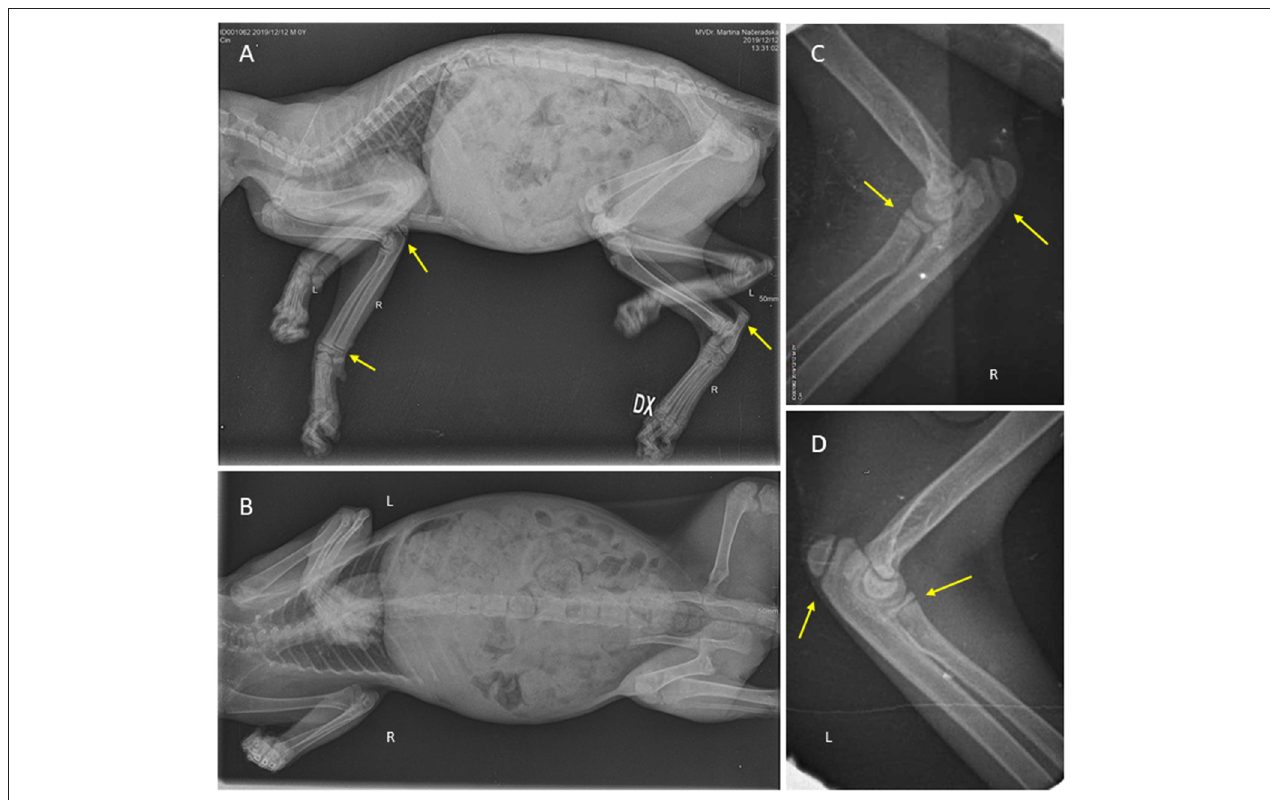
FIGURE 2 | Patient at the beginning of the therapy; whole-body X-ray show normal mineralization of the bones, and no fractures present. (A) Lateral position with marked normal growth plates (yellow arrows). (B) Ventrodorsal position. Elbows in detail. (C) Lateral position of the right elbow. (D) Lateral position of the left elbow, both with normal growth plates (yellow